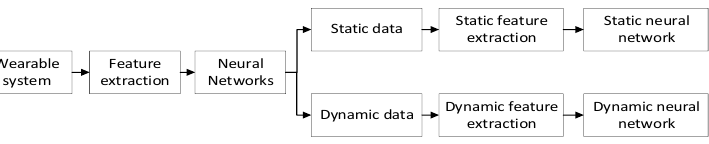
周期数 ( b ) Figure 7. ( a ) Hip angle comparison curve; ( b ) Knee angle comparison curve.